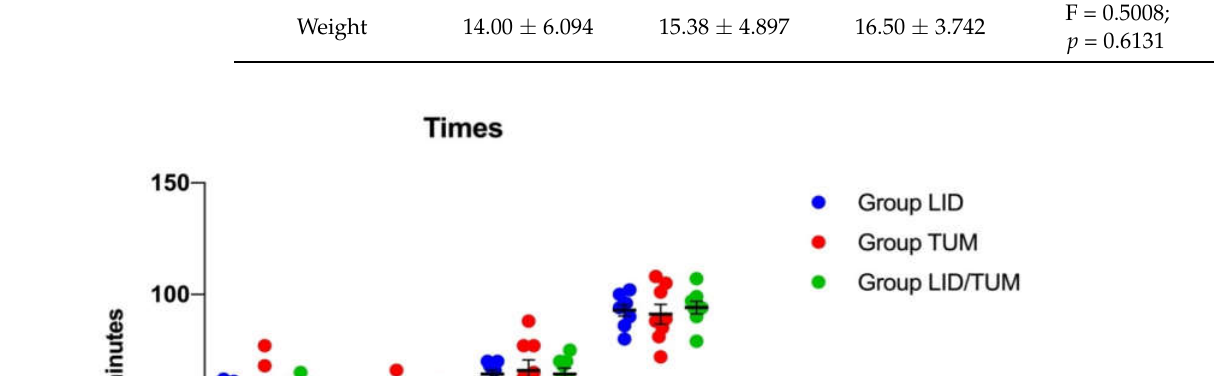
Table 1. Mean values and standard deviations of age and weight in the three groups. LID: Lidocaine group; TUM: Tumescent anesthesia group; LID/TUM: Lidocaine/Tumescent anesthesia group.